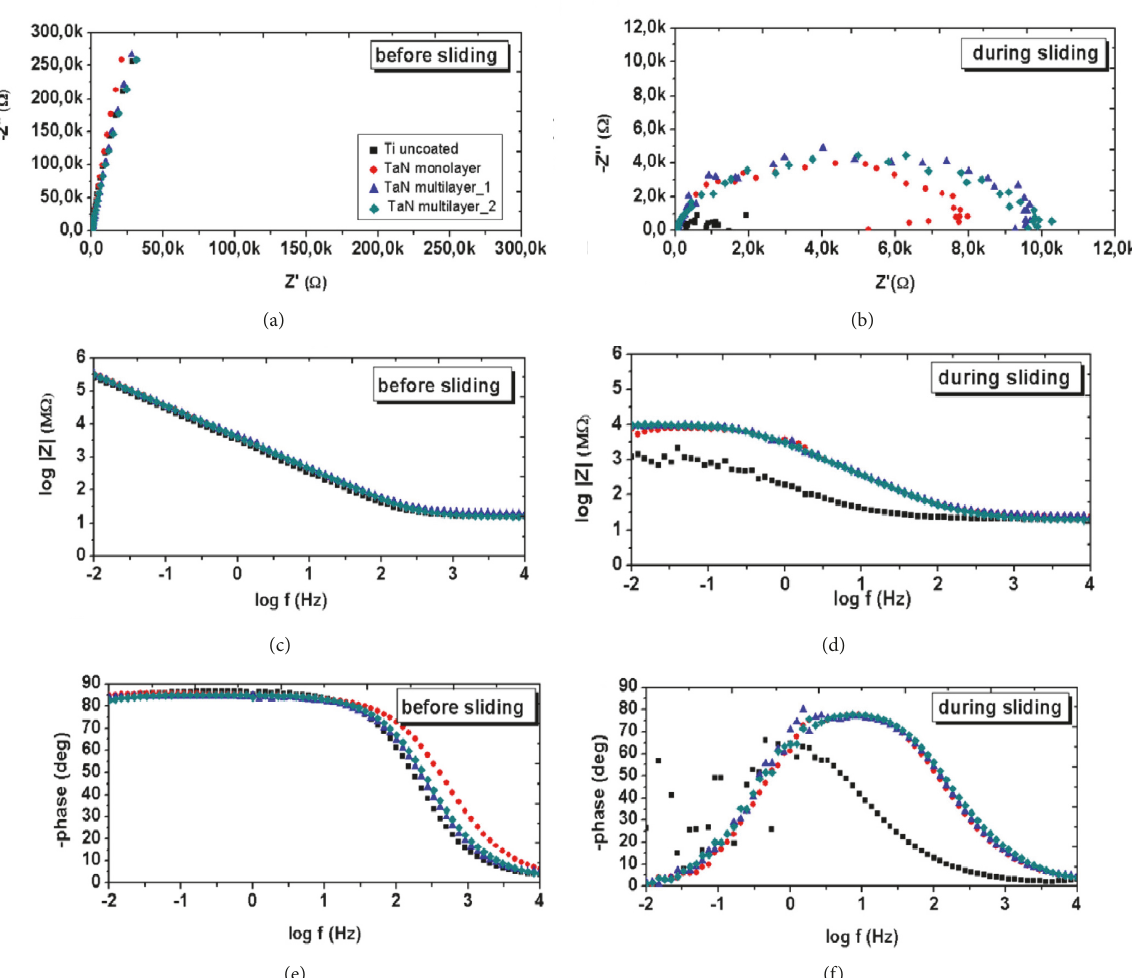
Figure 9: Nyquist and Bode plots of the EIS measurements performed before (a,c,d) and during (b,d,f) sliding process, for a titanium alloy and a TaN-coated titanium alloy in PBS solution. A decrease in the resistance is observed due to wear processes in both titanium and TaN coatings, but the resistance of the coatings was an order of magnitude higher than for the uncoated alloy